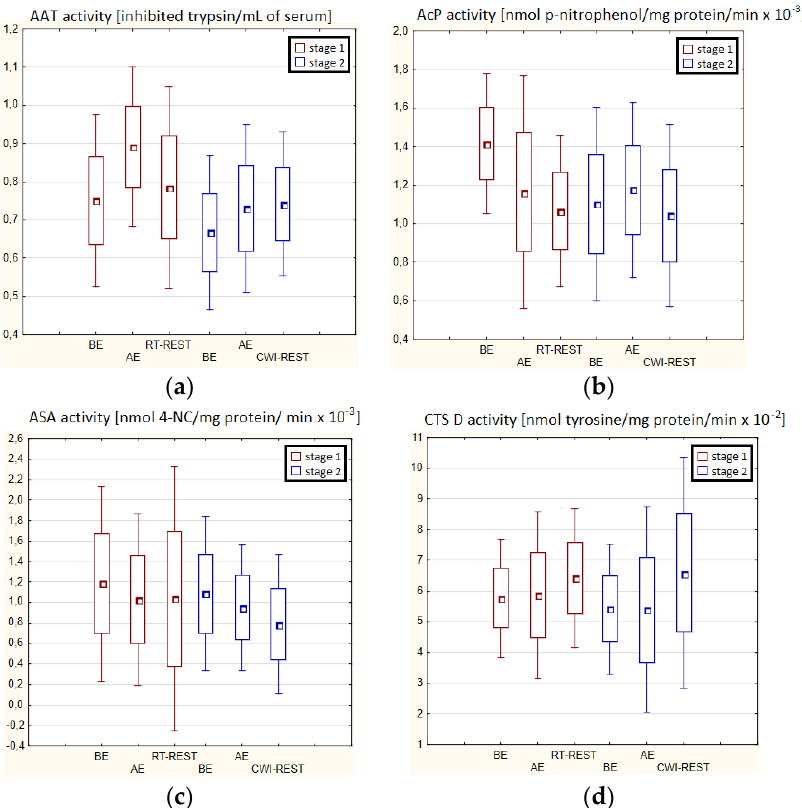
Figure 2. The activities of α 1-antytrypsin and lysosomal enzymes in blood serum of winter swimmers ( n = 22) in Experiment I: ( a ) AAT activity; ( b ) AcP activity; ( c ) ASA activity; ( d ) CTS D activity. Data are presented as the mean values ± SD. AAT— α 1-antytrypsin, AcP—acid phosphatase, ASA—arylsulfatase, CTS D—cathepsin D, BE—before exercise, AF—after exercise, RT-REST—20-min recovery at room temperature, CWI-REST—20-min recovery at room temperature combined with 3-min cold water immersion.